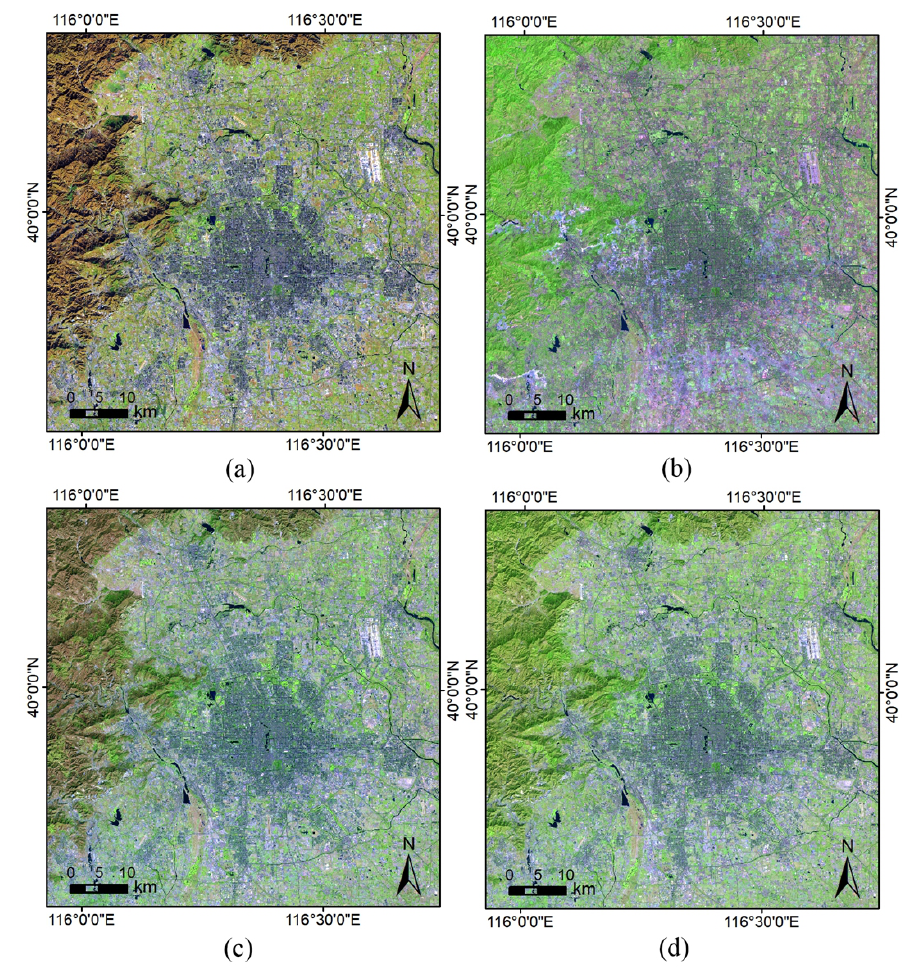
Figure 3. Different annual composite